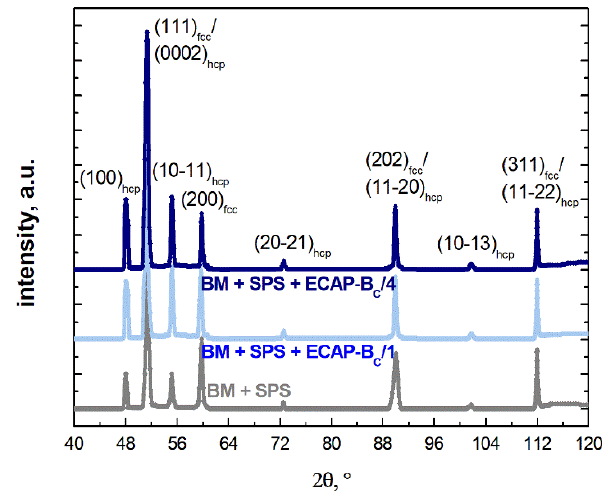
Figure 6. XRD patterns of BM + SPS (bottom-up process), BM + SPS + ECAP-B C /1, and BM + SPS + ECAP-B C /4 (top-down process). The 15-0806 (for fcc-Co) and 5-0727 (for hcp Co) JCPOS SPDD Metals and Alloys reference datasheets were used.